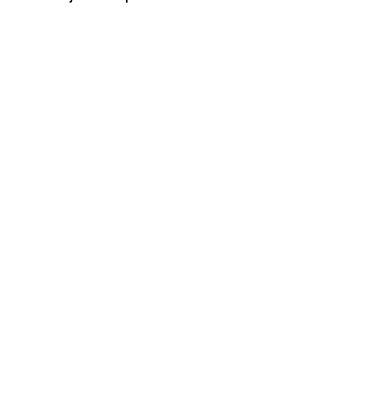
Short-term payments and birth with a skilled birth attendant. Seven studies considered effects of short-term cash payment programmes on births with a skilled birth attendant (Table A4 in S5 Appendix). Four controlled before-and-after studies (using sample sizes rang- ing from 4,770 women to 1,340,427 households) on Janani Suraksha Yojana in India found evidence that the programme increased births with a skilled birth attendant among recipients compared to non-recipients [34–36,39]. Two studies of Nepal’s Safe Delivery Incentive Pro- gramme (one cross-sectional study with a sample size of 5,901, and one retrospective area study with 14,799) found a positive benefit on outcomes assessed compared to control areas [41,42]. No evidence of effect was found by a retrospective area study (n = 20,133) on Nigeria’s SURE-P programme [44].